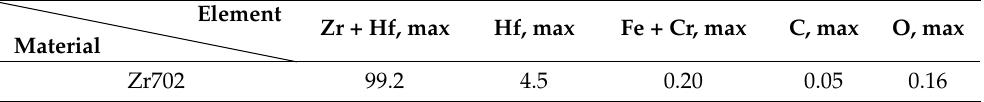
Table 1. The chemical composition (wt.%) of Zr 702